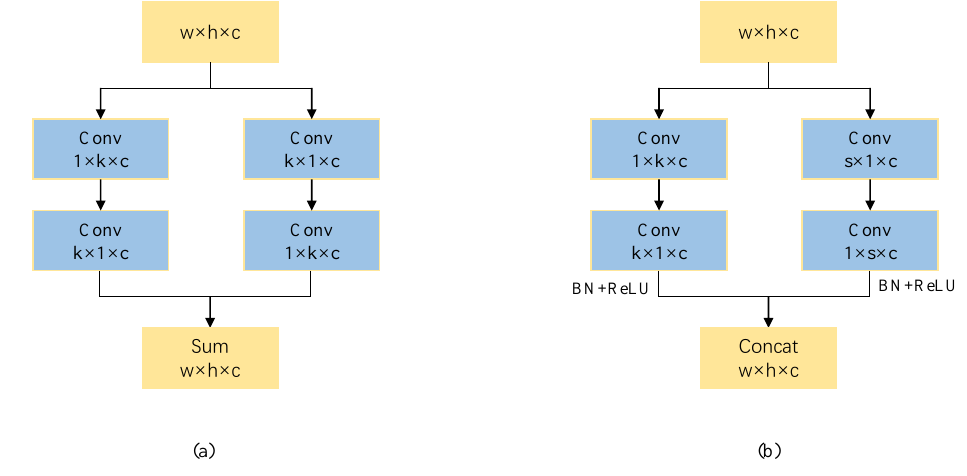
Figure 3. The differences between GCN and Hybrid-scale GCN. ( a ) GCN; ( b ) Hybrid-scale